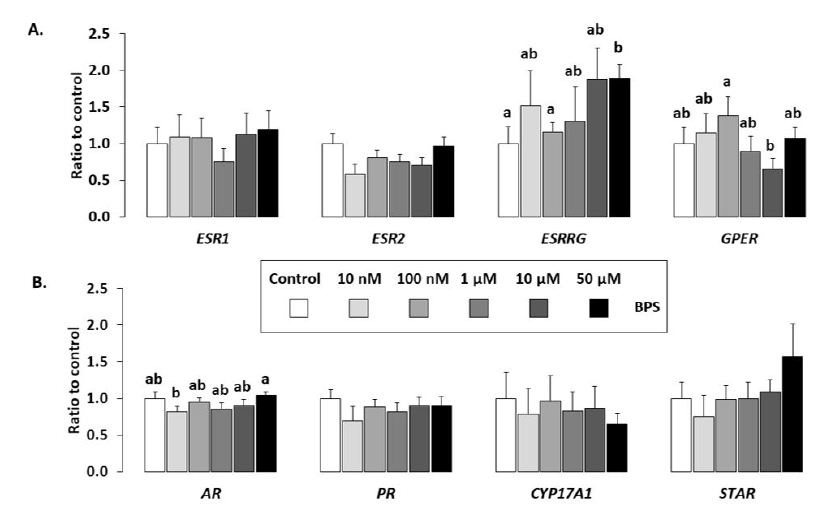
Figure 6. E ff ect of BPS on HGC gene expression. The expression of six hormonal receptors (oestrogen receptors (A): oestrogen receptor 1 [ESR1], oestrogen receptor 2 [ESR2], Oestrogen-related receptor γ [ESRRG] and G protein-coupled oestrogen receptor [GPER] and (B) androgen receptor [AR], progesterone receptor [PR]), and two genes involved in steroidogenesis (B: CYP17A1 and StAR), was determined in HGC after 48-h culture in complemented serum-free McCoy’s 5A media in the presence or absence of BPS (10 nM, 100 nM, 1 µ M, 10 µ M or 50 µ M). Total messenger RNA (mRNA) was extracted from HGC and reverse transcribed, and real-time polymerase chain reaction (qPCR) was performed. The geometric mean of two housekeeping genes (Glyceraldehyde-3-phosphate dehydrogenase [GAPDH] and ribosomal protein L19 [RPL19]) was used to normalise gene expression. The results are expressed as mean ± standard error of the mean (SEM) of six independent cultures and normalised to the mean of control condition. No letter in common indicates a significant di ff erence ( p <